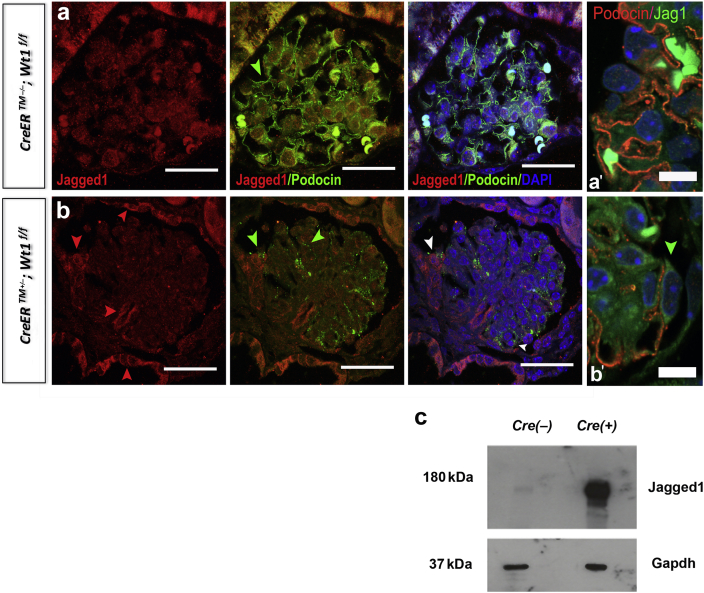
Jagged 1 is expressed in glomeruli of CAGG-CreERTM−/+;Wt1f/ftransgenic mice at day (D) 6 postinduction (PI). (a,b) Shown are representative images of glomeruli following double immunofluorescence labeling of D6 PI mouse kidney sections with anti-Jagged1 and anti-Podocin of CAGG-CreERTM−/−;Wt1f/f (controls, a) and CAGG-CreERTM+/−;Wt1f/f (mutant, b) mice following multichannel labeling with Alexa Fluor 488–conjugated secondary antibody (Podocin, demarcates podocytes) and Alexa Fluor 594–conjugated secondary antibody (Jagged1). Sections are counterstained with 4′,6-diamidino-2-phenylindole (DAPI). Red arrows show positive Jagged1 staining in the parietal epithelium, areas of podocyte adhesion (on the surface of Podocin-positive podocytes, green arrows, [b]; white arrows in merged image) to Bowman’s capsule and in the glomerular stalk of mutant glomeruli that are not evident in control glomeruli. Bar = 50 μm. (a′,b′) Higher-power views showing perimembranous expression of Jagged1 (green) in Podocin-positive podocytes (red) in mutants (b′) compared to controls (a′). (c) Representative images are shown of Western blot analyses of protein derived from primary podocytes isolated from mutants and control mice. Immunoblots show that Jagged1 is increased at D6 PI in mutant podocytes but not in controls. To optimize viewing of this image, please see the online version of this article at www.kidney-international.org.